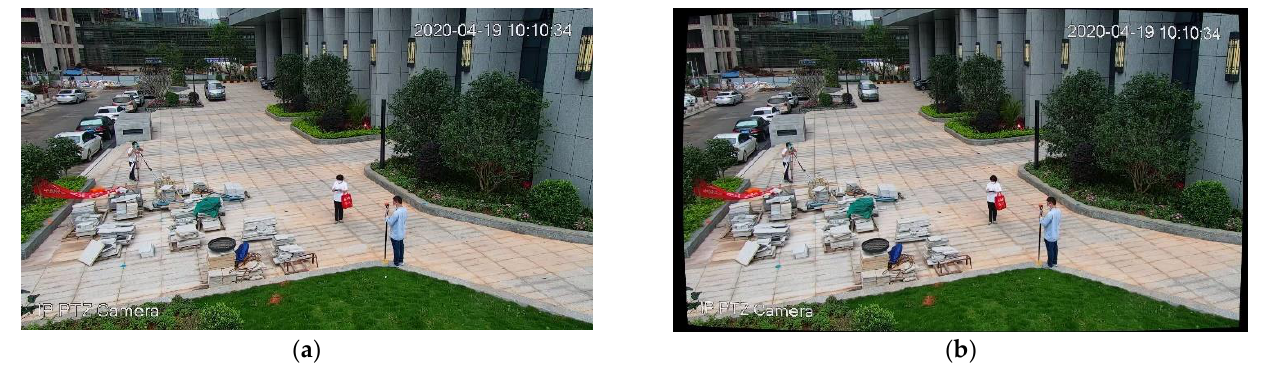
Figure 6. Measuring the three-dimensional coordinates of landmarks. ( a ) Before the distortion correction; ( b ) after the distortion correction. Table 1. Point pairs corresponding to image coordinates and world coordinates.